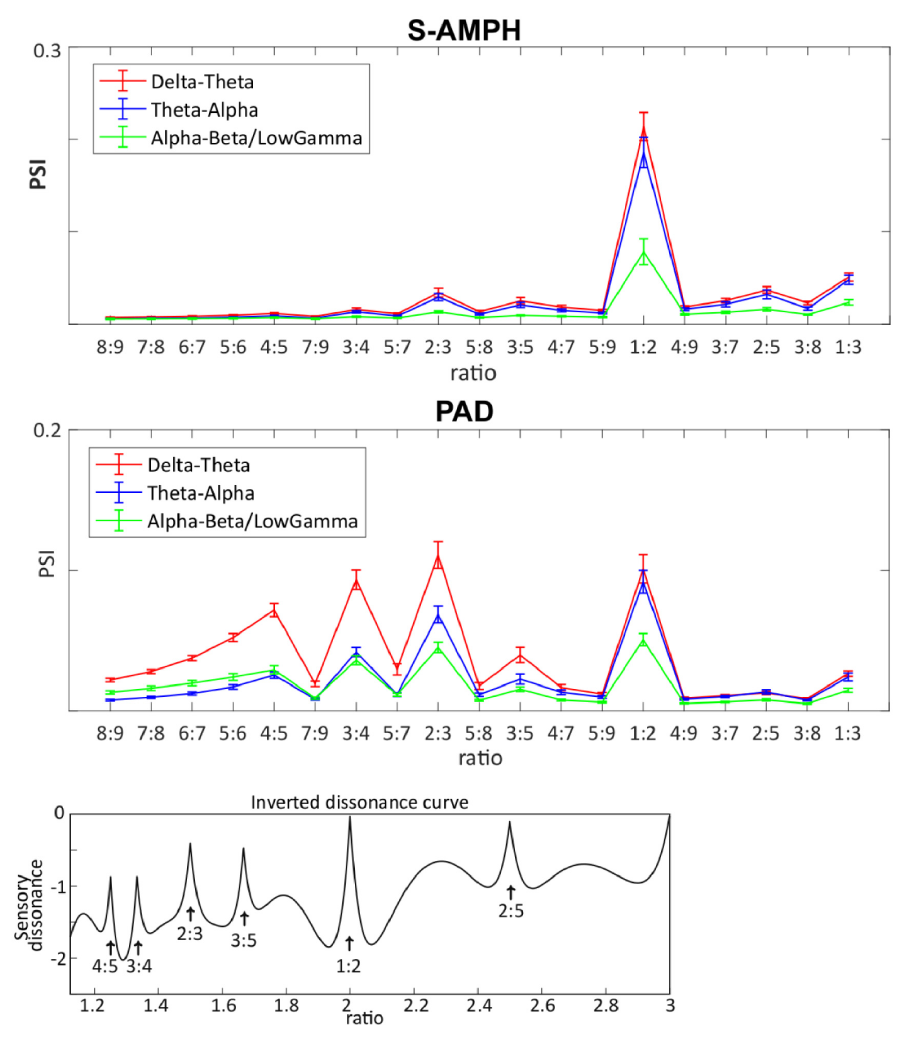
Fig 4. Phase synchronization index between different tiers in the amplitude modulation hierarchy for music. Both S-AMPH (a) and PAD models (b) showed that the simpler integer ratios (i.e., m/n) synchronize their phase with each other. The inverted dissonance curve (c) was obtained by including the first five upper partials of tones with a 440 Hz (i.e., pitch standard, A4) fundamental frequency in calculating the total dissonance of intervals [82]. It is of note that the peaks of PSI demonstrated by PAD correspond to those of the dissonance